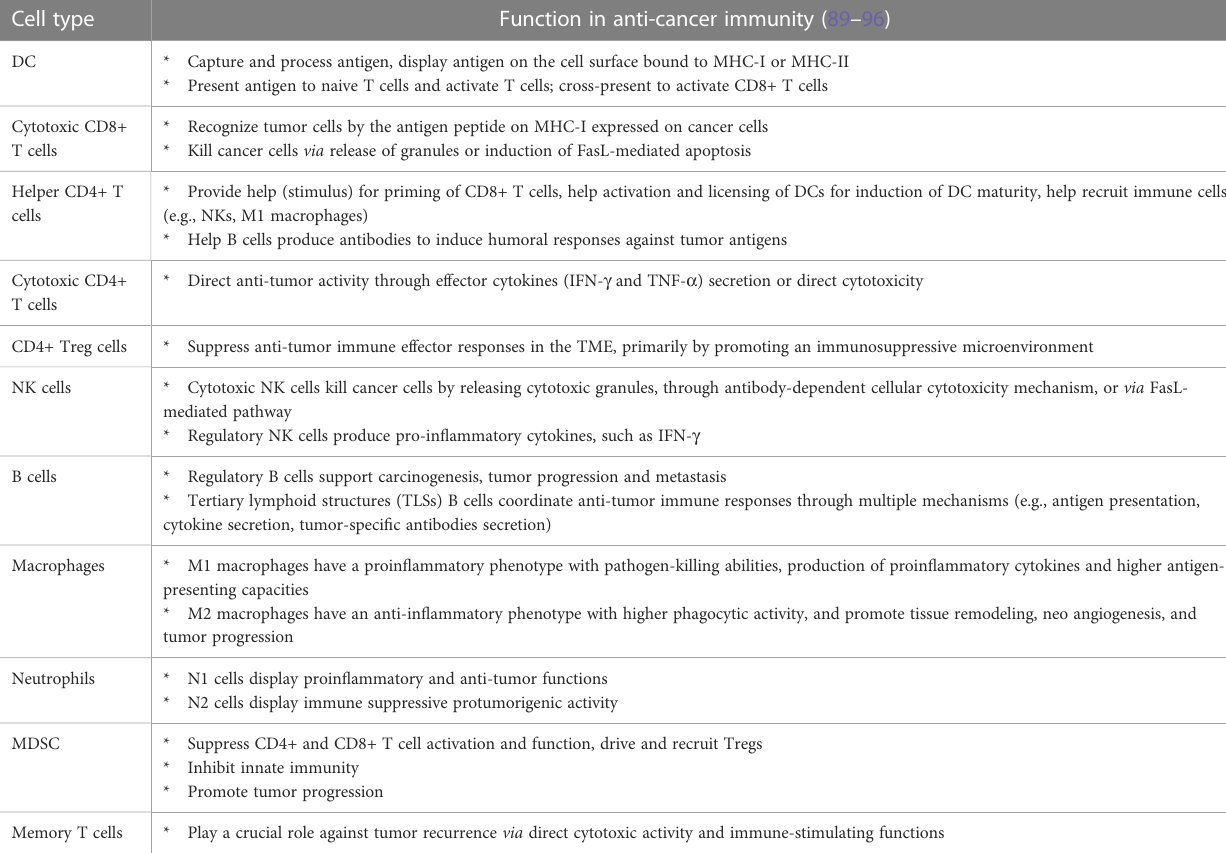
TABLE 4 Major immune cells involved in FT-induced anti-cancer immune response, based on their respective functional roles.